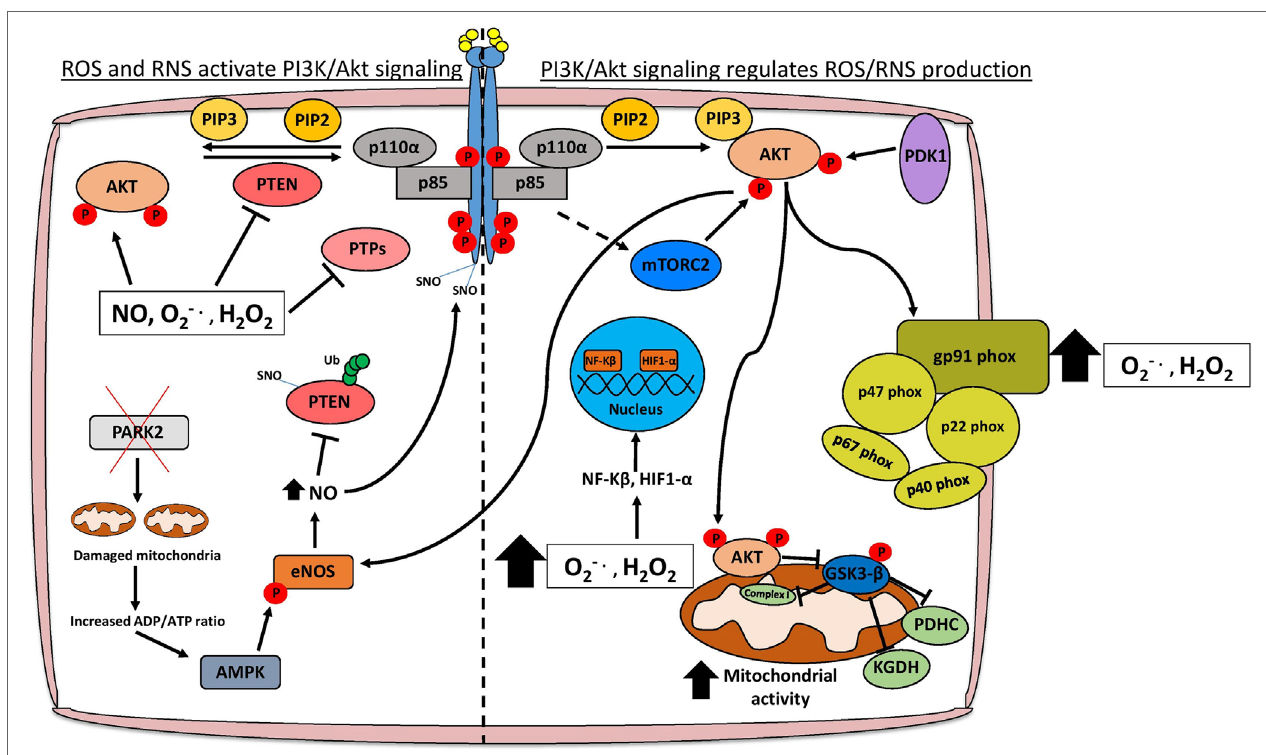
FiGURe 1 | Schematic representation of the interplay between PI3K/Akt signaling and redox stress. Activation of PI3K/Akt signaling occurs following stimulation of receptor tyrosine kinases (RTKs) or G-protein-coupled receptors. AKT is an important oncogenic effector of PI3K signaling and positively regulates reactive oxygen/ nitrogen species (ROS/RNS) production through direct modulation of mitochondrial bioenergetics and activation of NADPH oxidases. Cellular ROS levels can also potentiate the PI3K cascade by directly activating AKT, stimulating RTKs through SNO, or through inhibition of various tumor suppressor proteins such as PTEN and PTPs. Moreover, elevated ROS levels promote the nuclear translocation of NF- κβ and HIF1- α which transcriptionally regulate several genes involved in cancer cell growth, proliferation, and survival. Abbreviations: PTP, protein tyrosine phosphatase; SNO, S-nitrosylation; O 2 •− , superoxide; H 2 O 2 , hydrogen peroxide; NO, nitric oxide; eNOS, endothelial nitric oxide synthase; Ub, ubiquitin; PDHC, pyruvate dehydrogenase complex; KGDH, alpha-ketoglutarate dehydrogenase; PTEN, phosphatase and tensin homolog; PI3K, phosphoinositide